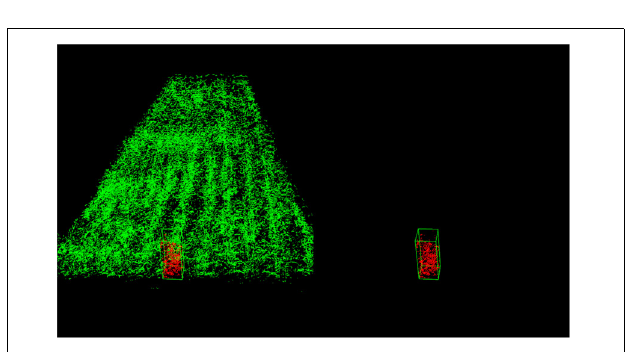
FIGURE 19 | Single plant detection for parcel-1. The detected single plant cloud is in red and marked out with a green bounding